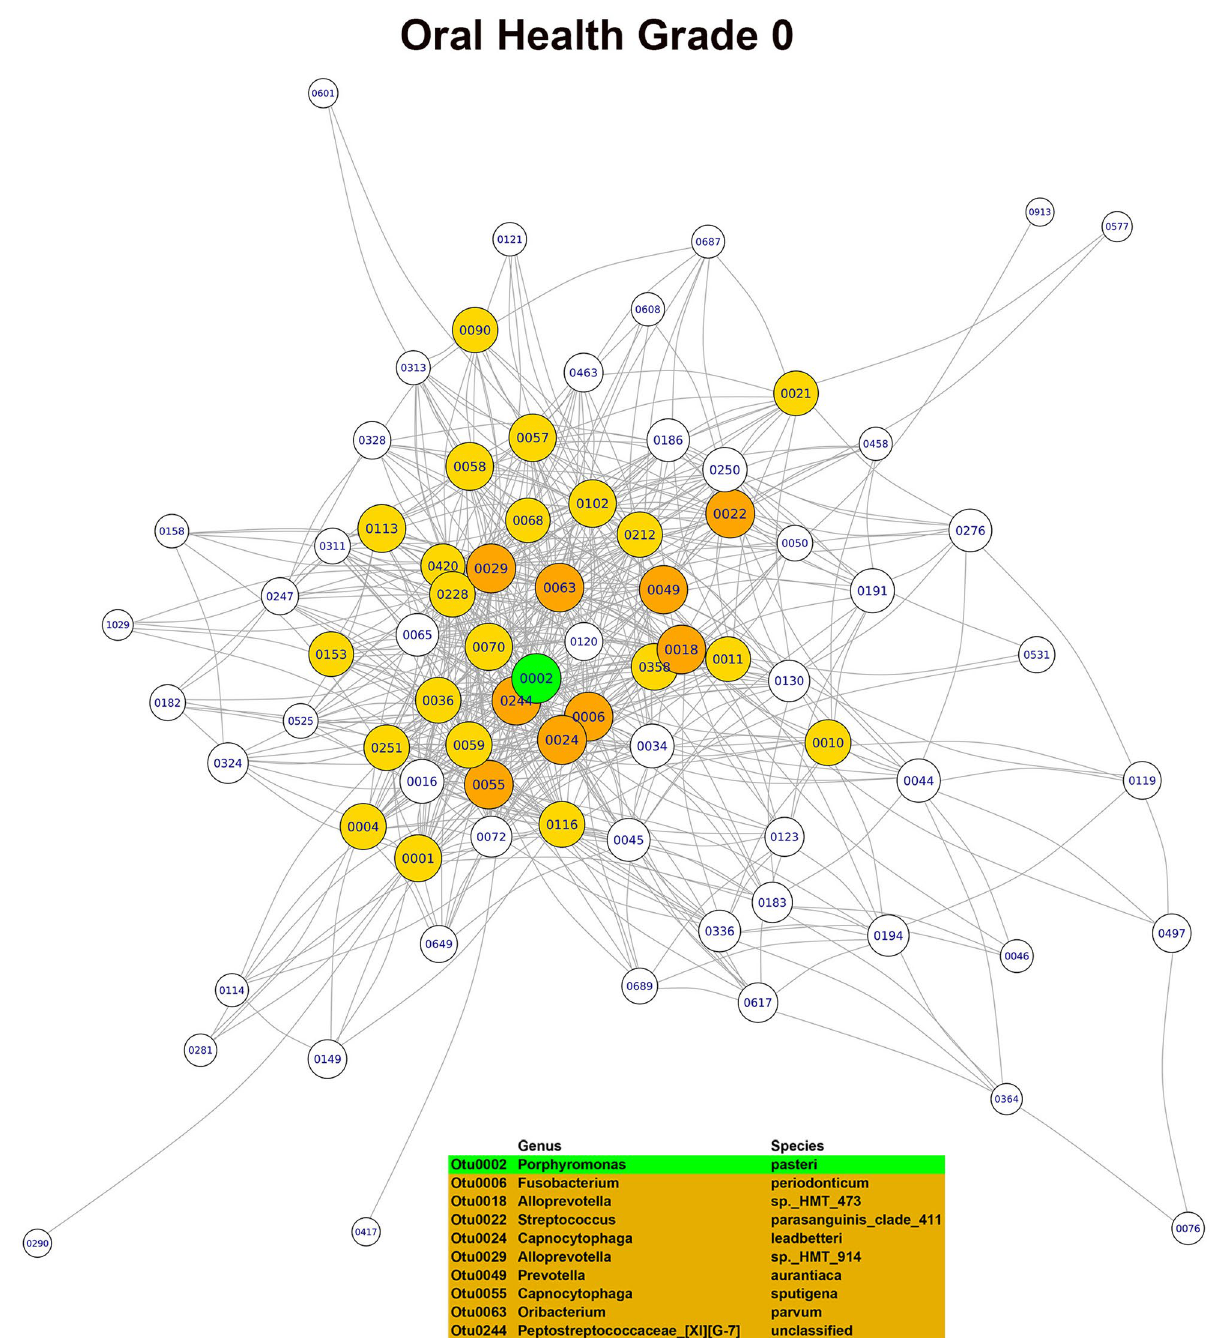
Figure 3. Main module of the co-occurrence network associated with grade 0 of the overall oral health scale (node = 79; degree = 1723) (graphic made using the igraph package, version